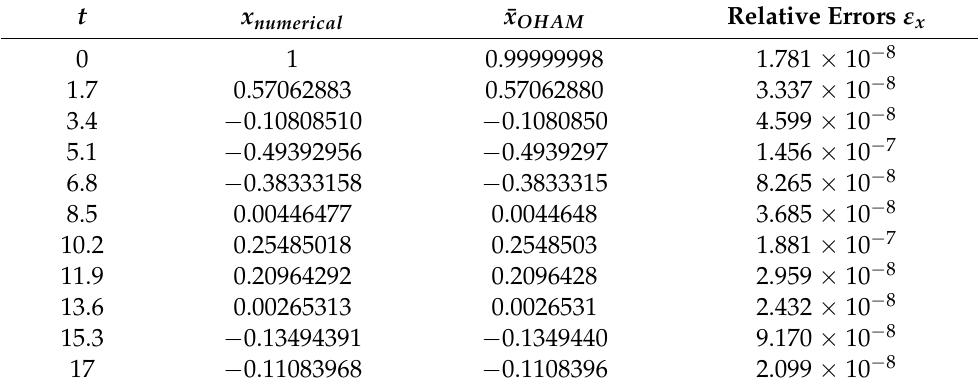
(cid:12) (cid:12) (cid:12) . (cid:12) x numerical − ¯ x OHAM